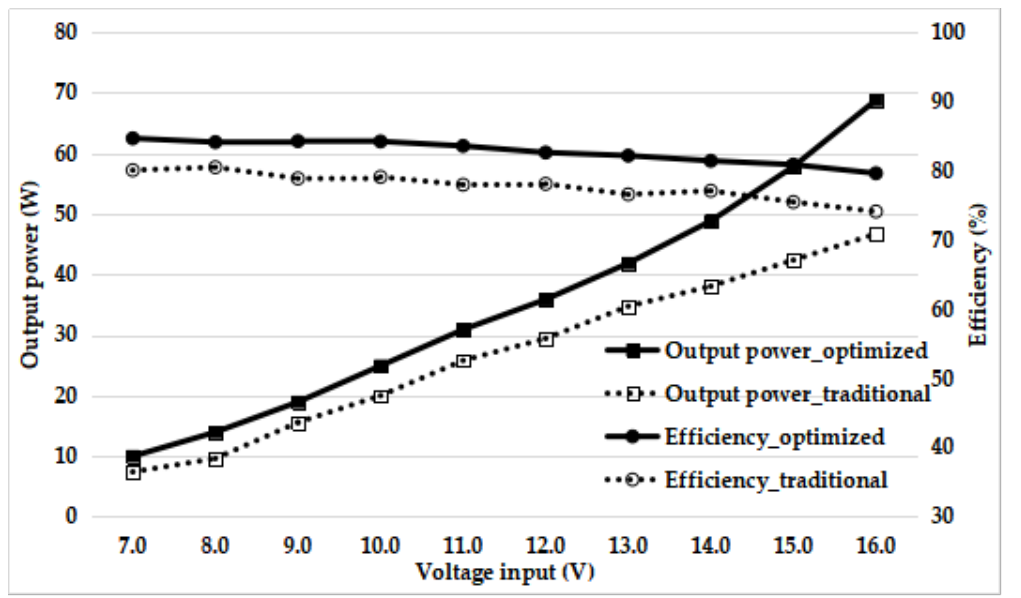
Figure 31. Experimental results of power output and total system